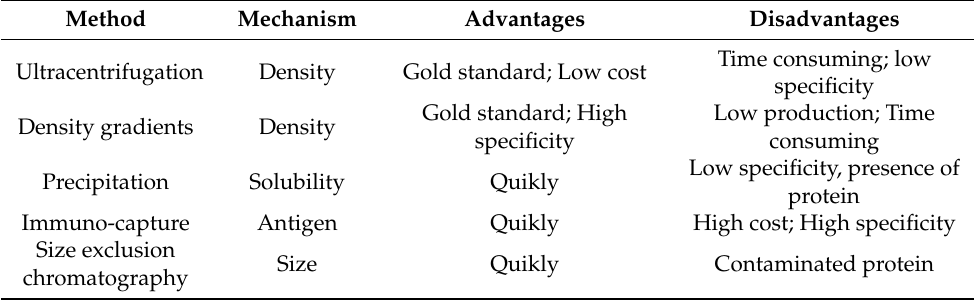
Table 1. Separation methods for sEVs.